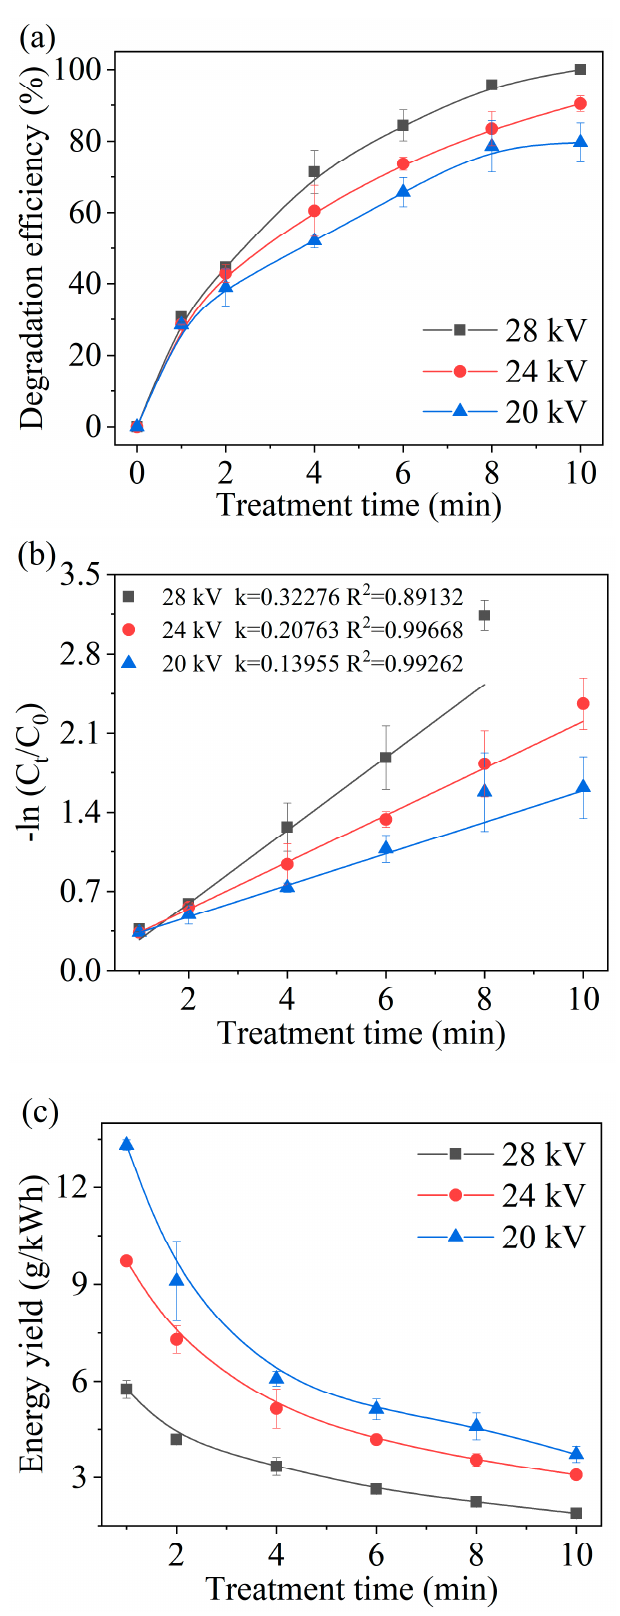
Figure 4. Effect of pulse peak voltage on ( a ) PYR removal efficiency, ( b ) pseudo-first-order kinetics, Figure 4. E ff ect of pulse peak voltage on ( a ) PYR removal e ffi ciency, ( b ) pseudo- fi rst-order kinetics, and ( c ) energy efficiency (pulse repetition rate: 150 Hz; initial concentration: 20 and ( c ) energy e ffi ciency (pulse repetition rate: 150 Hz; initial concentration: 20 mg/L).